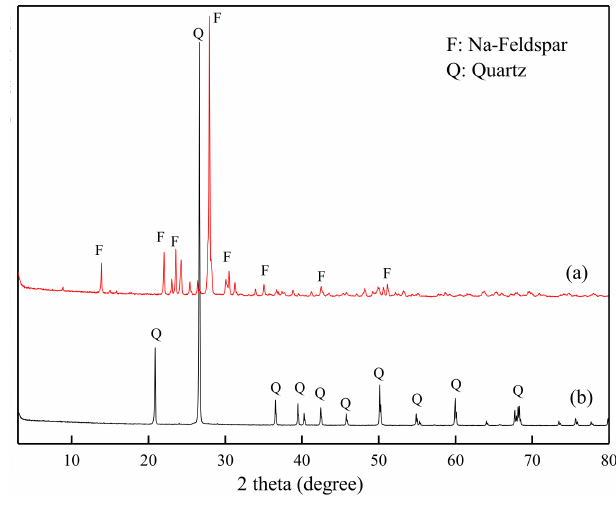
Figure 1. X-ray diffraction (XRD) spectra of the purified feldspar (a) and quartz